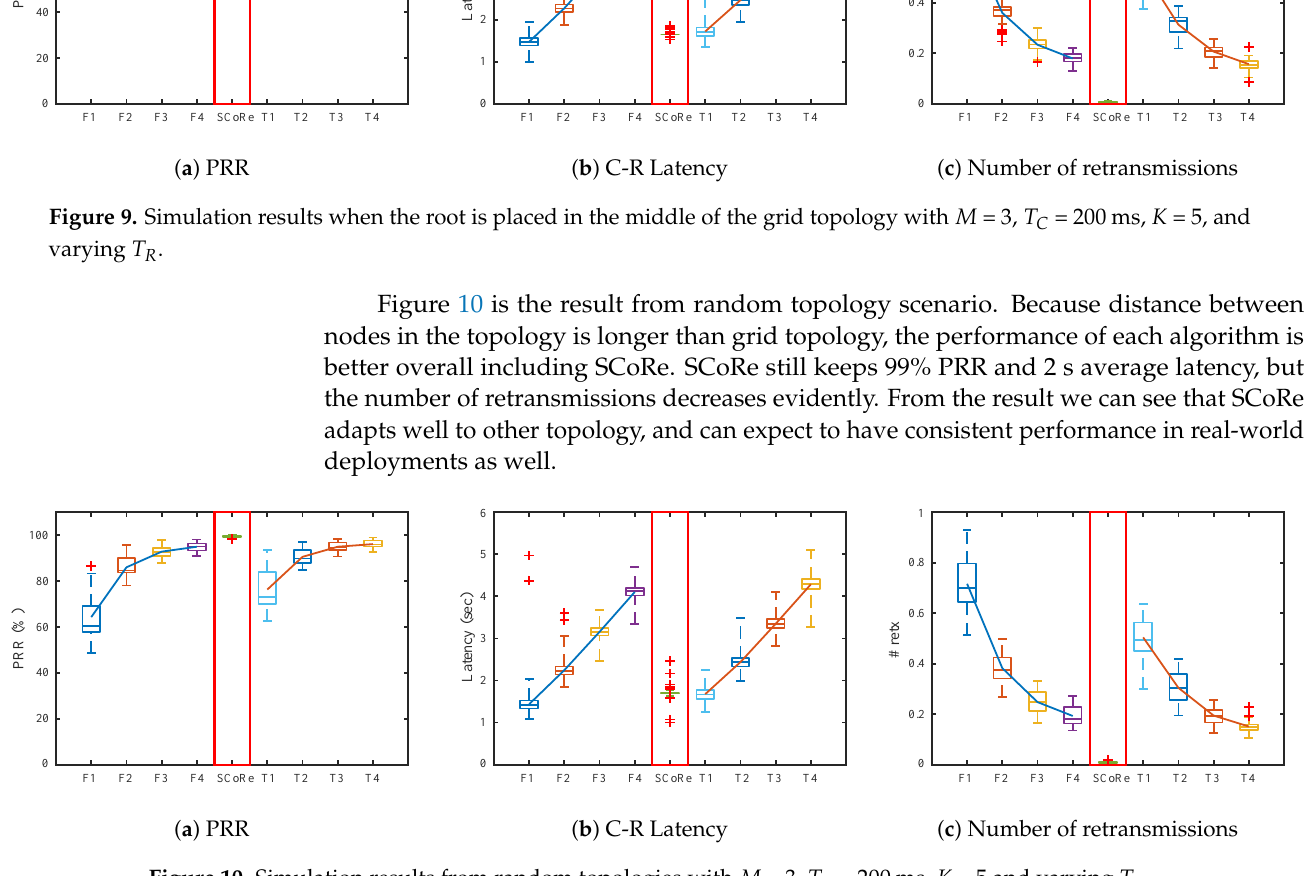
Figure 10. Simulation results from random topologies with M = 3, T C = 200 ms, K = 5 and varying T R